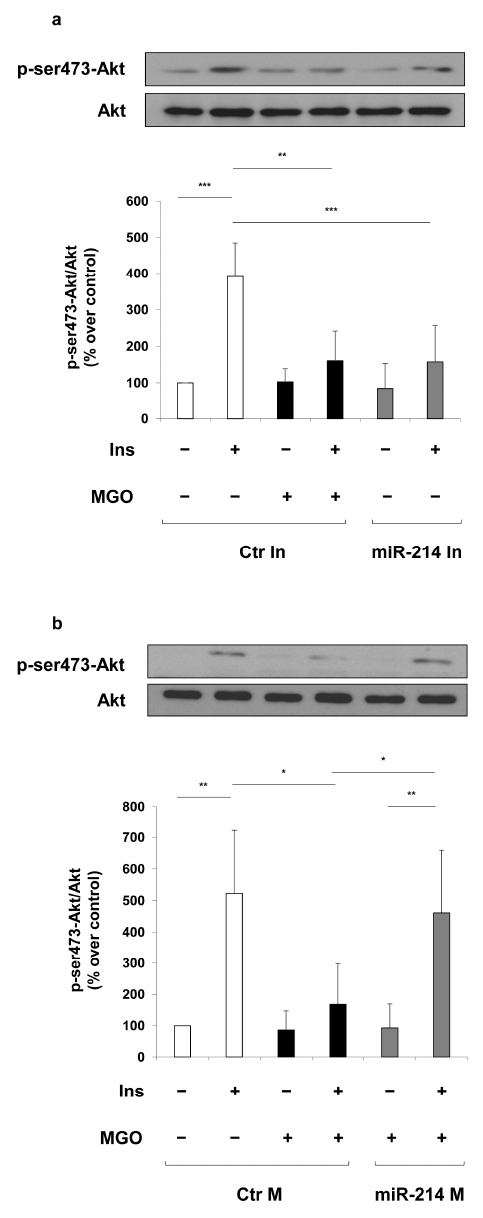
Figure 5. Effect of miR-214 modulation on insulin-dependent Akt activation in MAECs. MAECs were transfected with a non-targeting antisense inhibitor (Ctr In 0.5 nmol/L; ( a )) or a non-targeting control oligonucleotide (Ctr M 50 nmol/L; ( b )) (white and black bars), with miR-214 inhibitor ( a ) or miR-214 mimic ( b ) (miR-214 In 0.5 nmol/L or miR-214 M 50 nmol/L; gray bars). Where indicated, MAECs were treated with 500 μ mol/L MGO (black bars) for 16 h before harvesting. After 48 h of transfection, cells were stimulated or not with 100 nmol/L insulin for 10 min. Protein lysates were analyzed by Western blot with p-ser473-Akt and Akt antibodies. Exposure timing was of 30 seconds. Protein levels were quantified by the densitometric analysis of at least three independent experiments. p-ser473-Akt levels were normalized to Akt total levels. Bars in the graphs represent the mean ± SD of the percent (%) over control (Ctr In and Ctr M). Statistical analysis was evaluated using the Student’s t -test; * p ≤ 0.05; ** p ≤ 0.01; *** p ≤ 0.001.